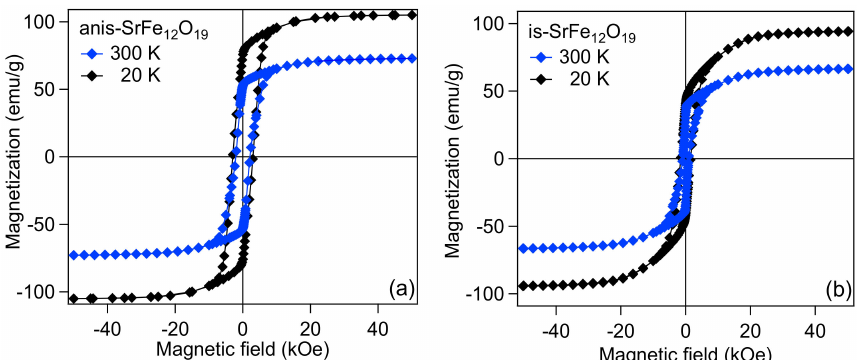
Figure 4. Magnetic hysteresis loops collected on the anis-SrFe 12 O 19 ( a ) and the is-SrFe 12 O 19 ( b ) ferrite particles at T = 20 K (black markers) and T = 300 K (blue